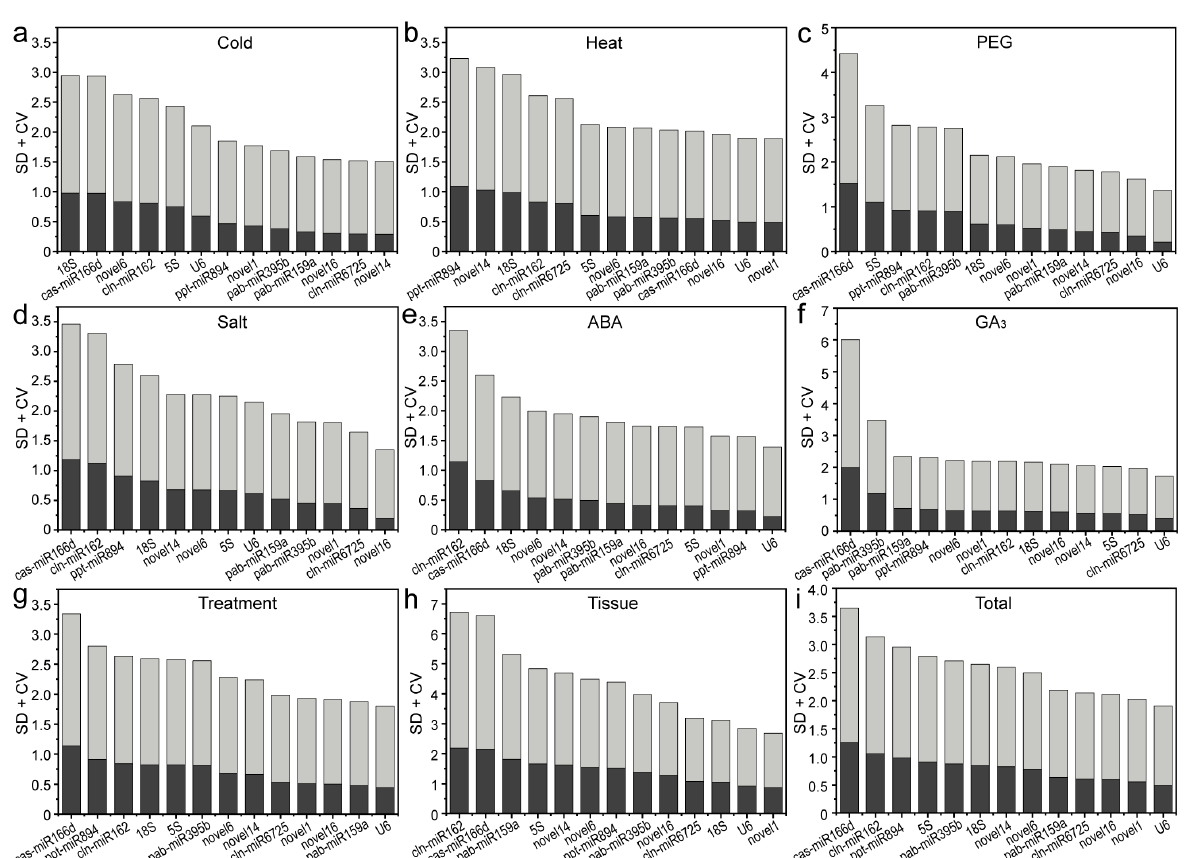
Figure 5. Stacked histograms showing the rankings of 13 candidate reference genes using the BestKeeper algorithm. Results from ( a ) 4 ◦ C cold stress; ( b ) 40 ◦ C heat stress; ( c ) drought stress simulated by 15% PEG-6000 treatment; ( d ) salt stress stimulated by 200 mM NaCl treatment; ( e ) 200 µ M ABA treatment; ( f ) 200 µ M GA 3 treatment; ( g ) multiple stresses; ( h ) different tissues (roots, stems, tender needles, cones and seeds); ( i ) total samples. Dark grey bars represent standard deviations (SDs) of average Ct values, and light grey bars represent coefficients of variance (CVs).